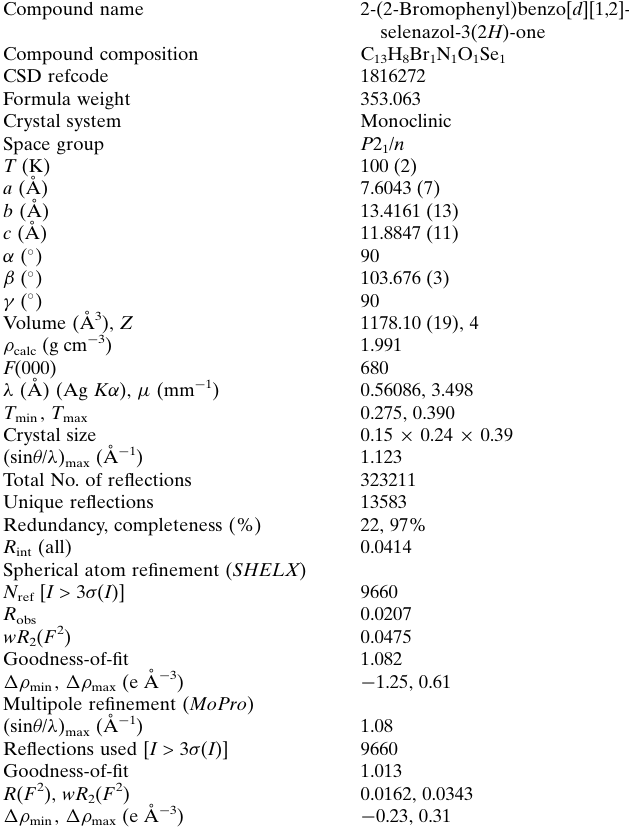
Table 1 Crystallographic